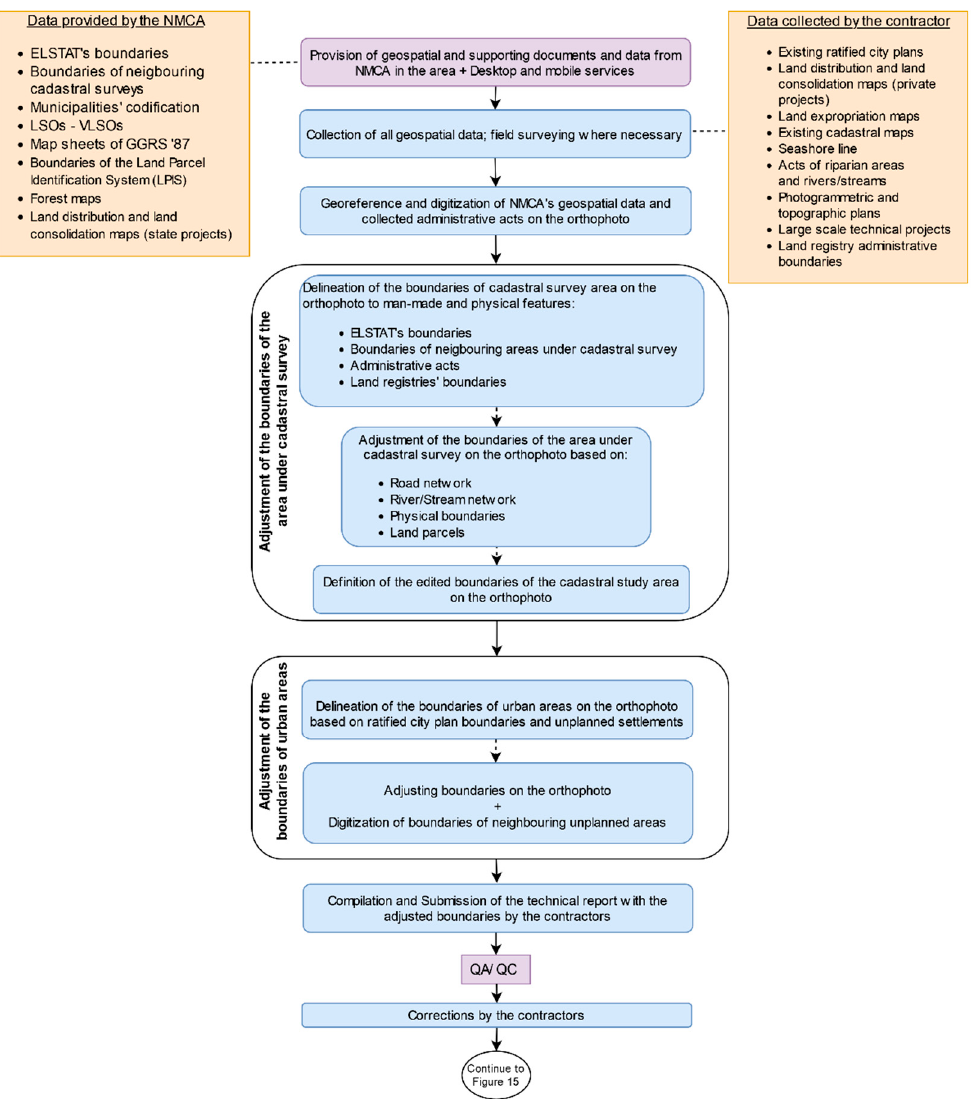
Figure 5. Procedure for the delineation of all administrative boundaries in the cadastral study area: NMCA’s actions (purple); contractors’ actions (blue).